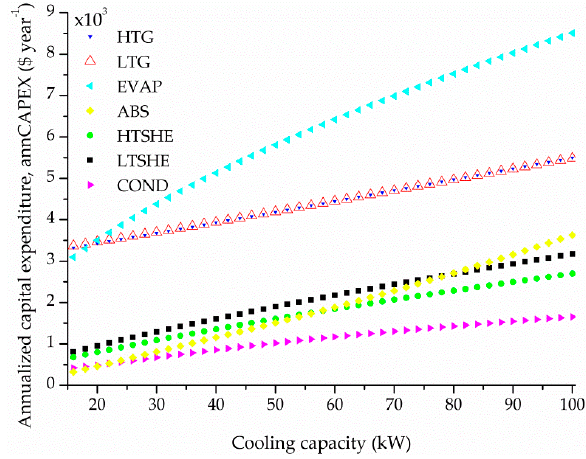
Figure 3. Optimal process-unit annCAPEX versus the cooling capacity.